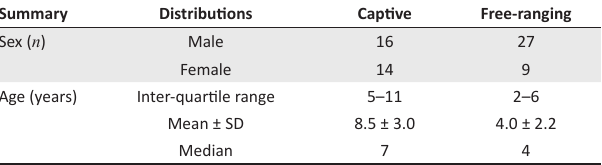
TABLE 1: Summary of sex and age distributions of captive and free-ranging Namibian cheetahs. Summary